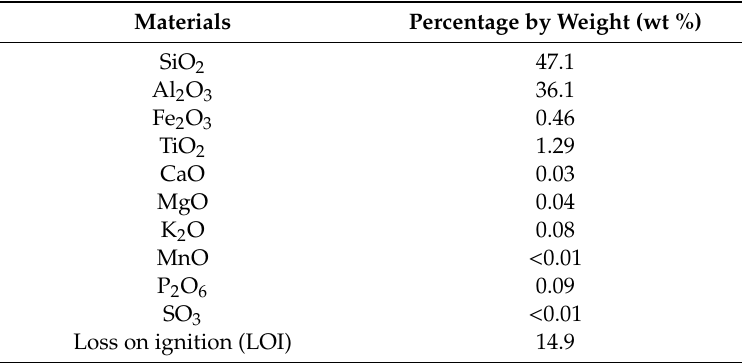
Table 3. Chemical composition of aluminous clay used in the